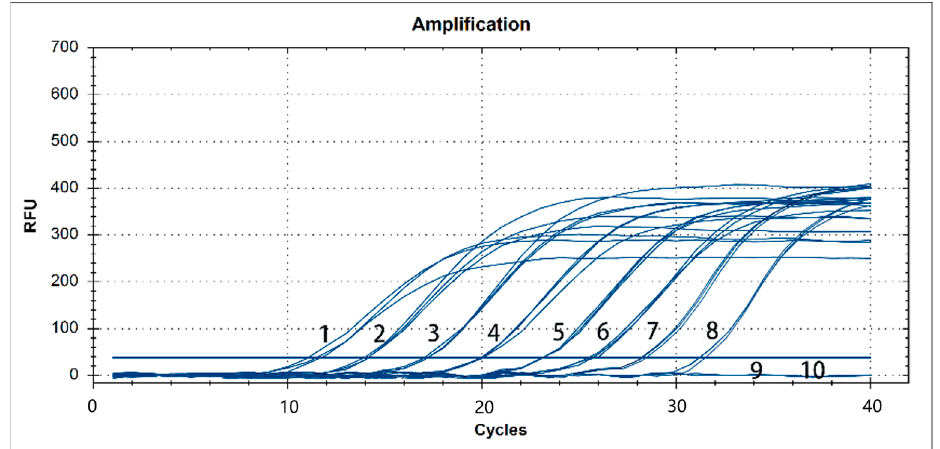
Figure 3. Sensitivity analysis of the TaqMan real-time RT-PCR for NADC34-like PRRSV. RFU: relative fluorescence units; 1–9: 7.80 × 10 8 copies/ µ L–7.80 × 10 0 copies/ µ L; 10: negative control(ddH 2 O). The lowest copy number detected by RT-qPCR was 7.80 × 10 1 copies/µL.